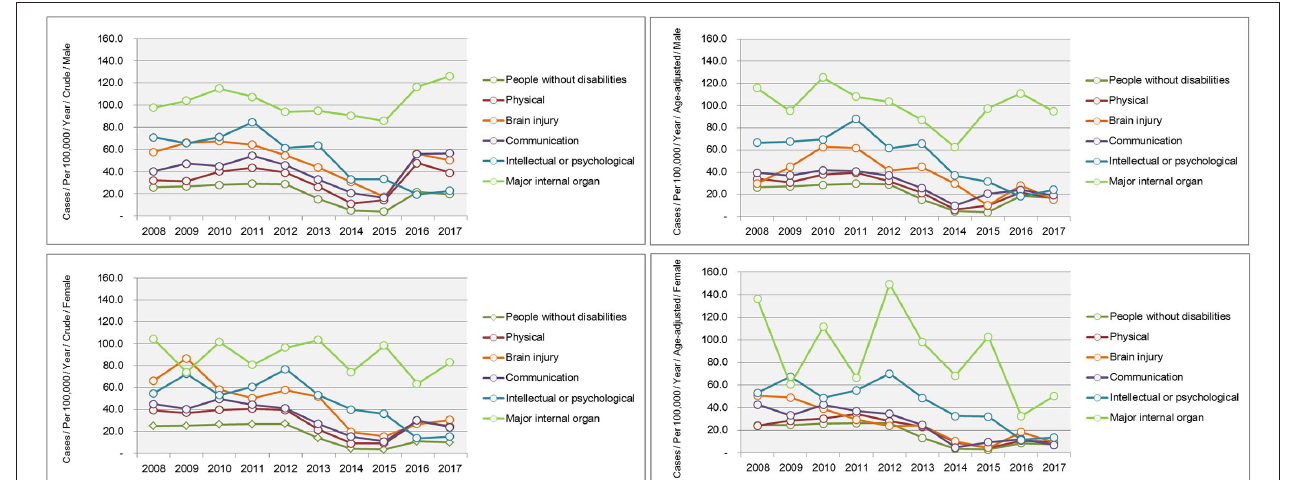
FIGURE 4 | Trends in the incidence of complicated appendicitis according to the type of a disability for 2008–2017.